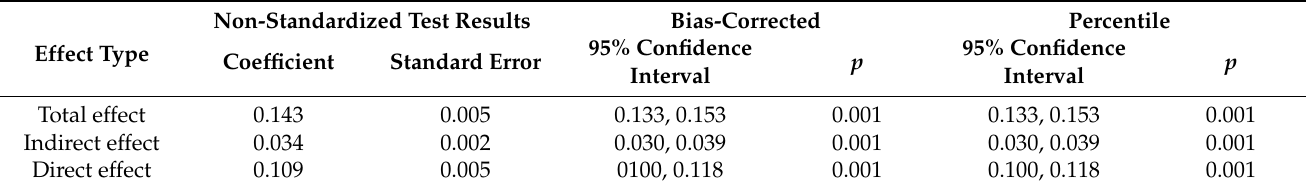
Table 15. Intermediary effect test